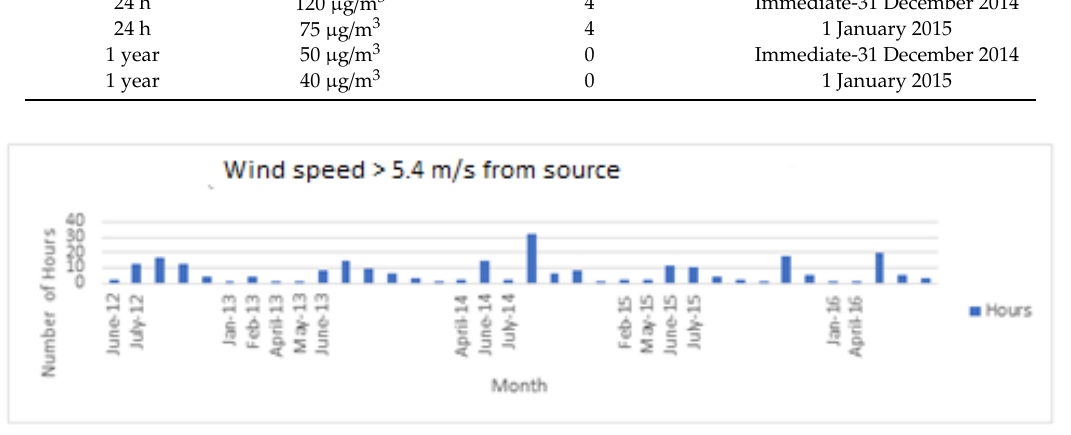
Figure A4. Wind speed > 5.4 m / s from the SW Sector. Table A4. National Dust Control Regulation.